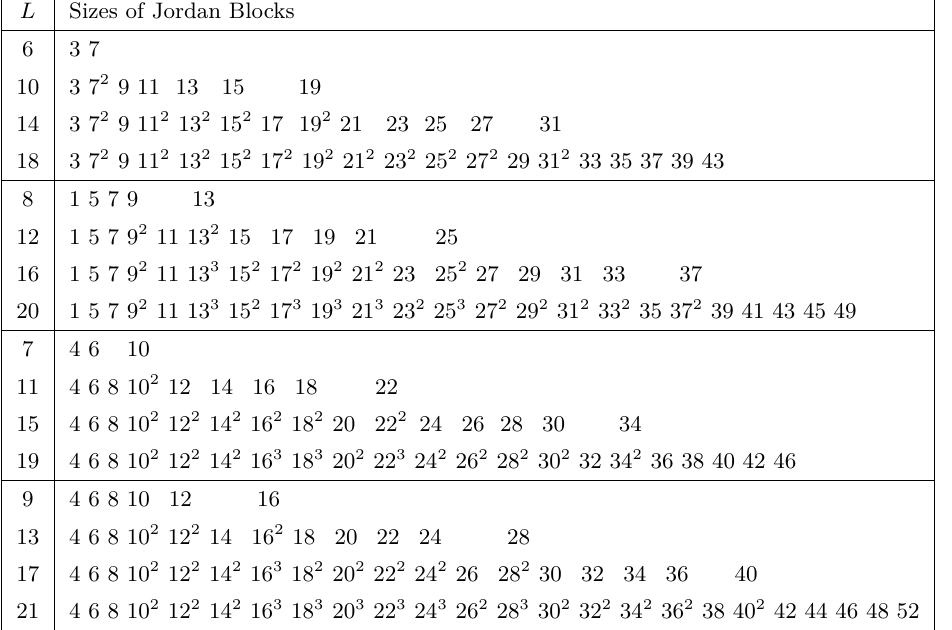
Table 2 . Structures of Jordan blocks for the sector of M = 4 , K = 1 , k = 0 (cyclic states). Exponents denote